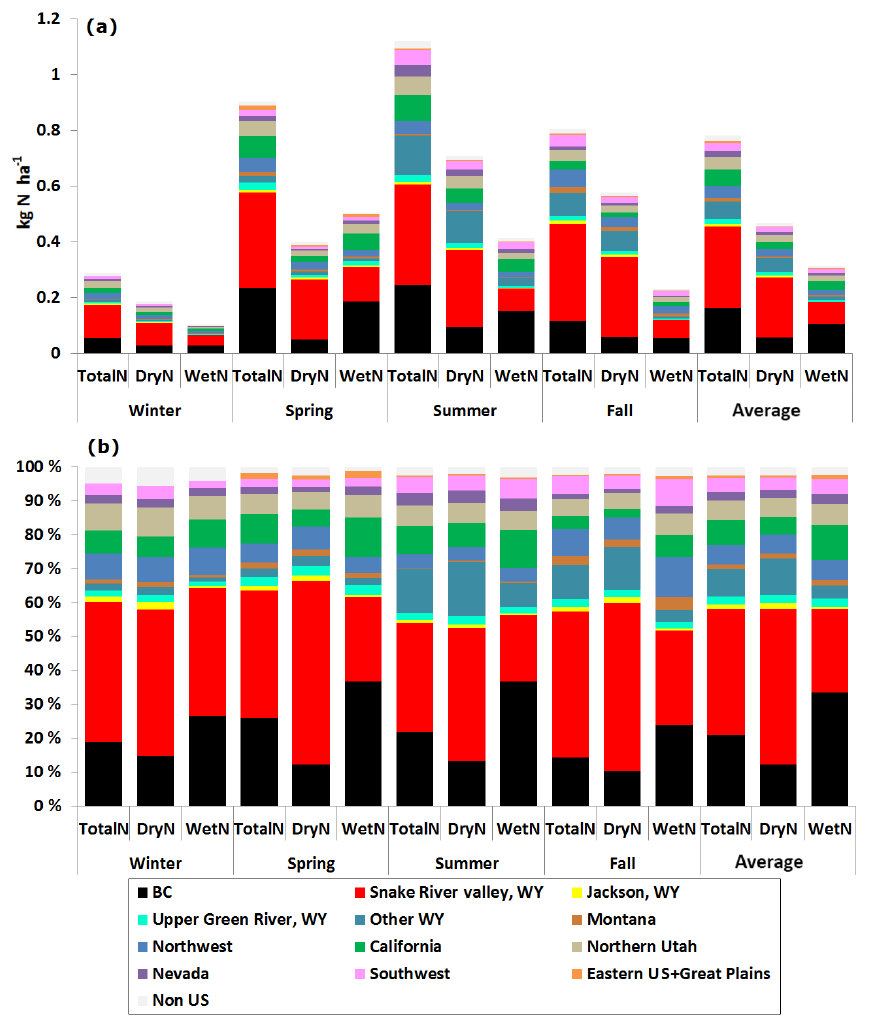
Figure 9. Contributions of source regions to the mean total N r deposition, dry N r deposition, and wet N r deposition over the GYA in different seasons in 2011. (a) The source region contributions as an absolute and (b) the corresponding contributions as a